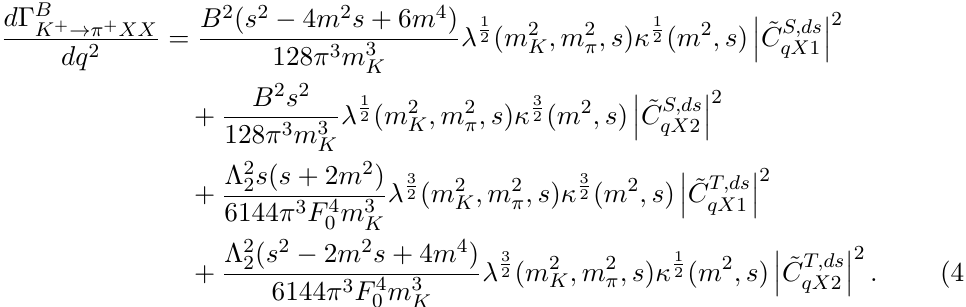
Figure 11 . Constraints on the effective new physics scale for the two operators O S,ds involving d, s quarks as a function of the DM mass m from K → π /E